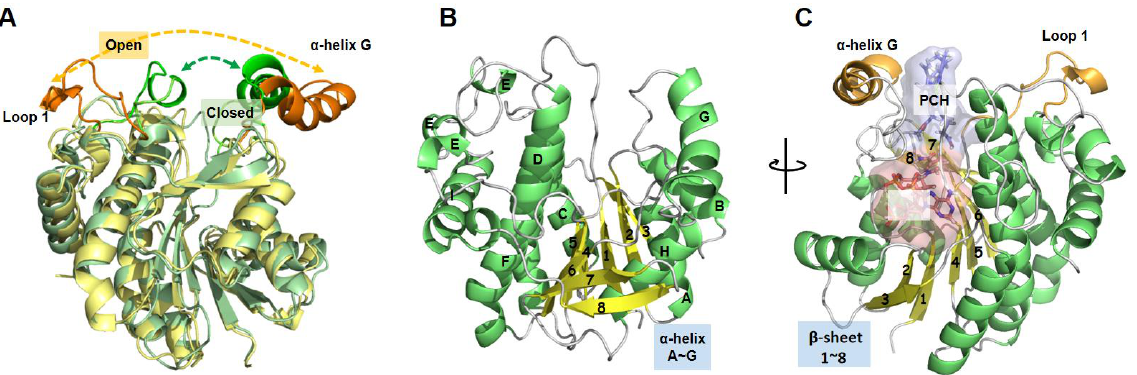
Figure 3. ( A ) Conformational superposition of Arabidopsis thaliana LPOR (PDB ID: 7JK9) and the constructed At LPOR in the “closed” (light green) and “open” (light yellow) state. The lid regions where the two proteins differ most are highlighted in green and orange, respectively. ( B ) The conformation of constructed At LPOR α -helices and β -sheets are shown in green and yellow, and connecting loop regions are shown in silver. ( C ) The constructed At LPOR/NADPH/Pchlide ternary